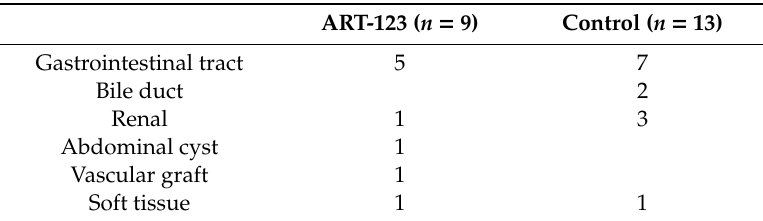
Table 4. Surgical treatments.